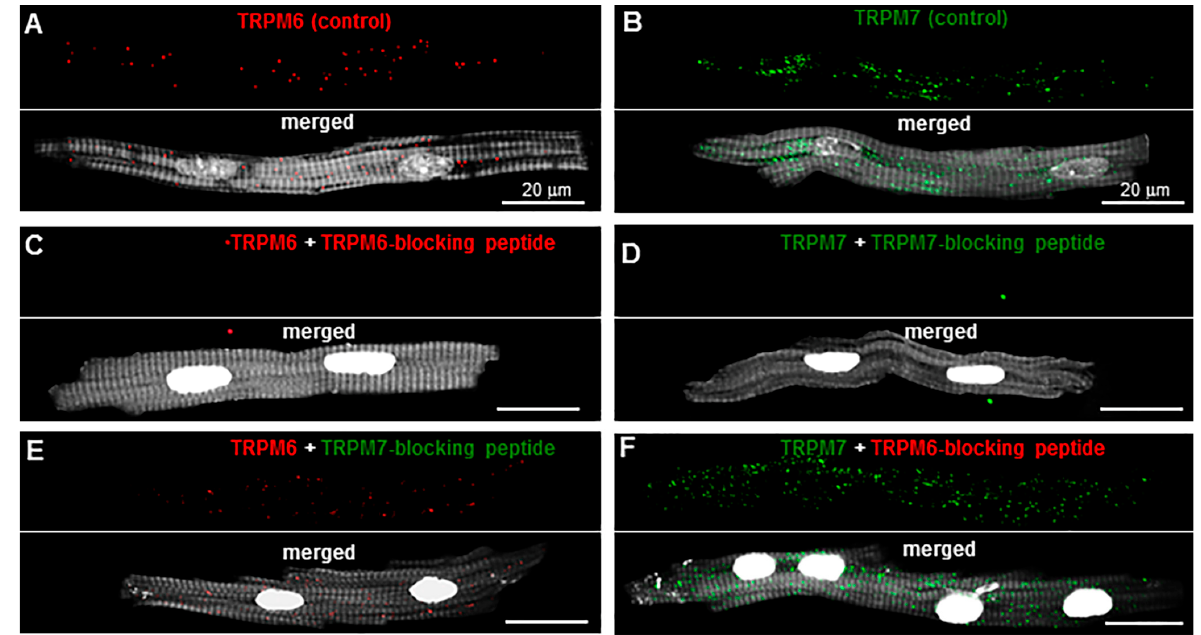
Figure 1. Specificity of antibody-based detection of TRPM6 and TPRM7 in pig right atrial (RA) cardiomyocytes: ( A , B ) Immunofluorescence signals in cells incubated with anti-TRPM6 (red, when using Alexa Fluor 546) or anti-TRPM7 (green, when using Alexa Fluor 488) antibodies used alone (upper panels). The immunofluorescence of TRPM6 was increased post-acquisition by a factor of 2 for better visualization of the red staining. Bottom panels show merged images in the same cells stained with either anti-TRPM6 or anti-TRPM7 as well as Phalloidin-CF 405 for filamentous actin (F-actin) cytoskeleton (in surrogate grey) and Hoechst 33342 for nuclei (in surrogate white); ( C , D ) immunofluorescence signals in cells incubated with anti-TRPM6 or anti-TRPM7 antibodies in the presence of antibody-blocking peptides (upper panels). Bottom panels show merged images in the same cells stained with either anti-TRPM6 or anti-TRPM7, together with the blocking peptides, as well as Phalloidin-CF 405 for F-actin cytoskeleton (in surrogate grey) and Hoechst 33342 for nuclei (in surrogate white). There was no staining with anti-TRPM6 (red) or anti-TRPM7 (green) in the presence of antibody-blocking peptides; ( E , F ) immunofluorescence signals in cells incubated with anti-TRPM6 antibodies in the presence of the TRPM7-blocking peptide or with anti-TRPM7 antibodies in the presence of the TRPM6-blocking peptide (upper panels). Bottom panels show merged images in the same cells stained with the anti-TRPM antibodies together with the off-target blocking peptides, as well as Phalloidin-CF 405 for F-actin cytoskeleton (in surrogate grey) and Hoechst 33342 for nuclei (in surrogate white). Staining was similar to that in conditions where there is no blocking peptide. Scale bars indicate 20 µm.